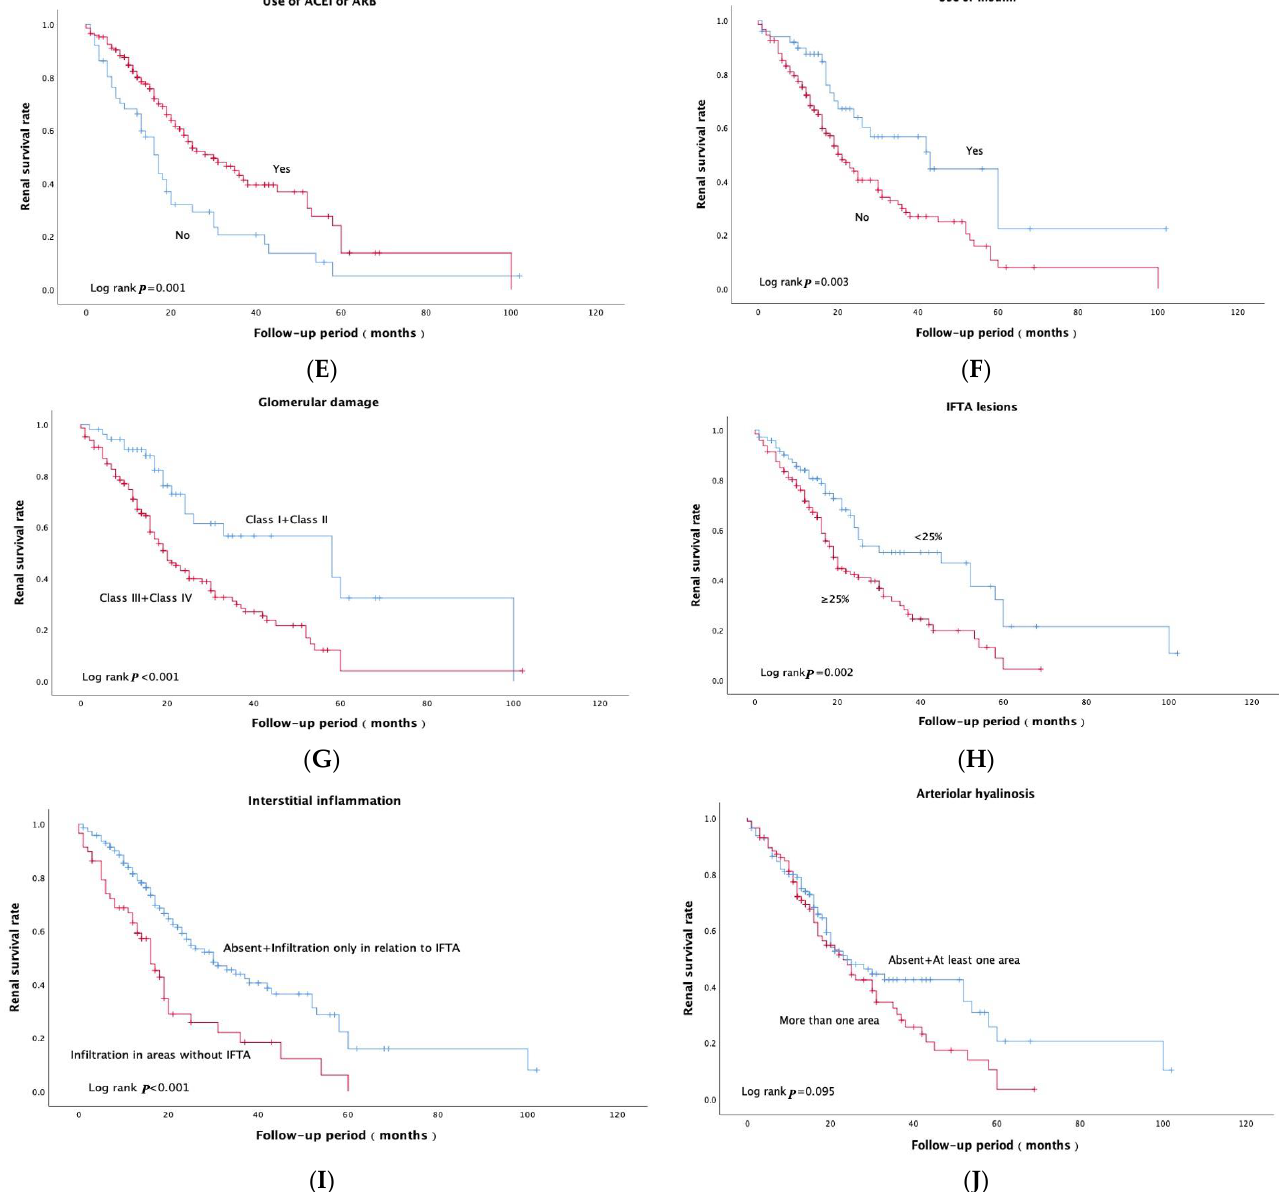
Figure 2. Kaplan – Meier curves of the renal survival rate in DKD patients with nephrotic range pro- teinuria ( A – J ). ( A ) Diabetes duration < 72 months group and diabetes duration ≥ 72 months group. ( B ) Albumin < 30 g/L group and a lbumin ≥30 g/L group. ( C ) e-GFR < 60 mL/min/1.73 m 2 group and e- GFR ≥60 mL/min/1.73 m 2 group. ( D ) Hemoglobin < 120 g/L group and h emoglobin ≥ 120 g/L group. ( E ) Patients treated with ACEI/ARB group and without ACEI/ARB group. ( F ) Patients treated with insulin group and without insulin group. ( G ) Glomerular damage (glomerular class I + II group and class III + IV group). ( H ) Interstitial fibrosis and tubular atrophy (IFTA), <25% group and ≥25% group. ( I ) Interstitial inflammation (0 + 1 group and 2 group). ( J ) Arteriolar hyalinosis (0 + 1 group and 2 group). Interstitial inflammation (0, absent; 1, infiltration only in relation to IFTA; 2, infiltration in areas without IFTA) arteriolar hyalinosis (0, absent; 1, at least one area of arteriolar hyalinosis; 2, more than one area of arteriolar hyalinosis).